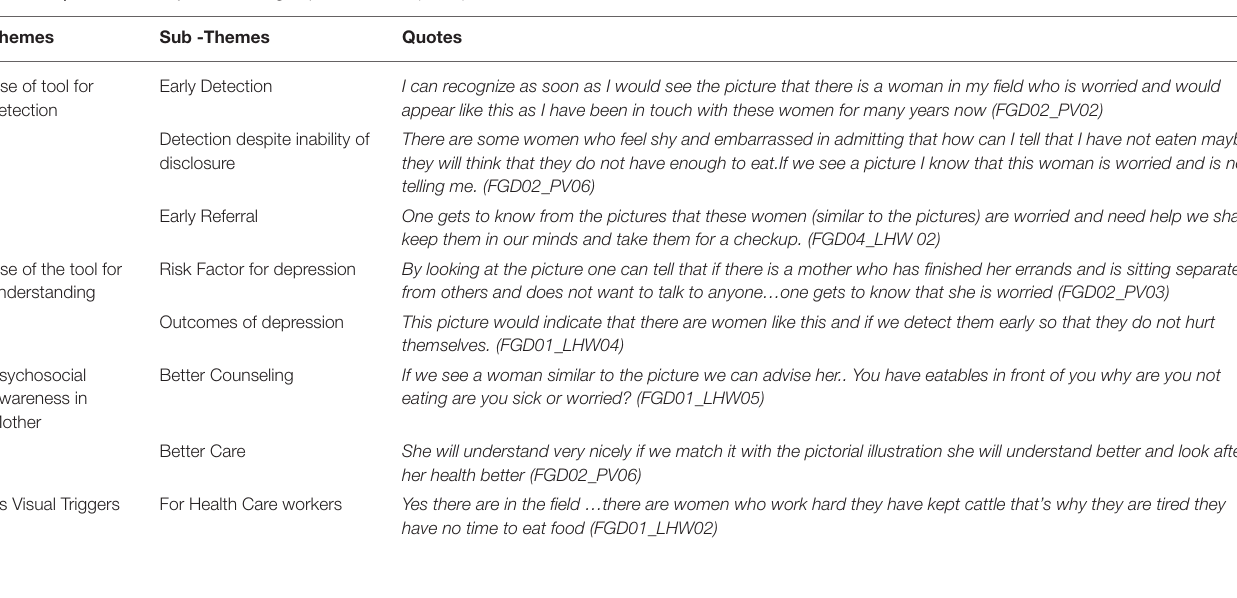
TABLE 5 | Thematic analysis of focus group discussions ( n =